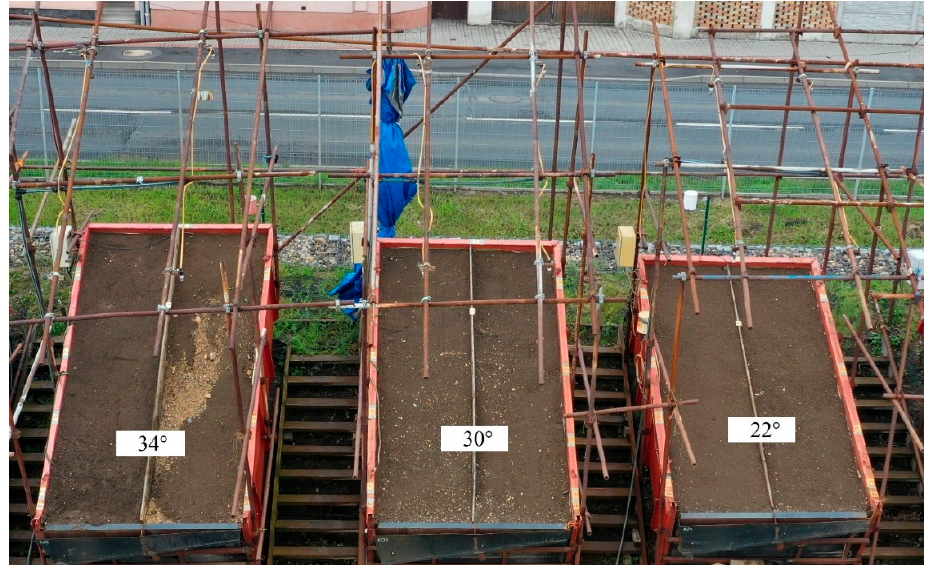
Figure 1. Experimental plots. Slope 34°, 30° and 22°. Dimensions 4.25 × 1 × 1.6 m. Rainfall simula- tor pulse nozzle system type WSQ 40. Location–Jirkov.